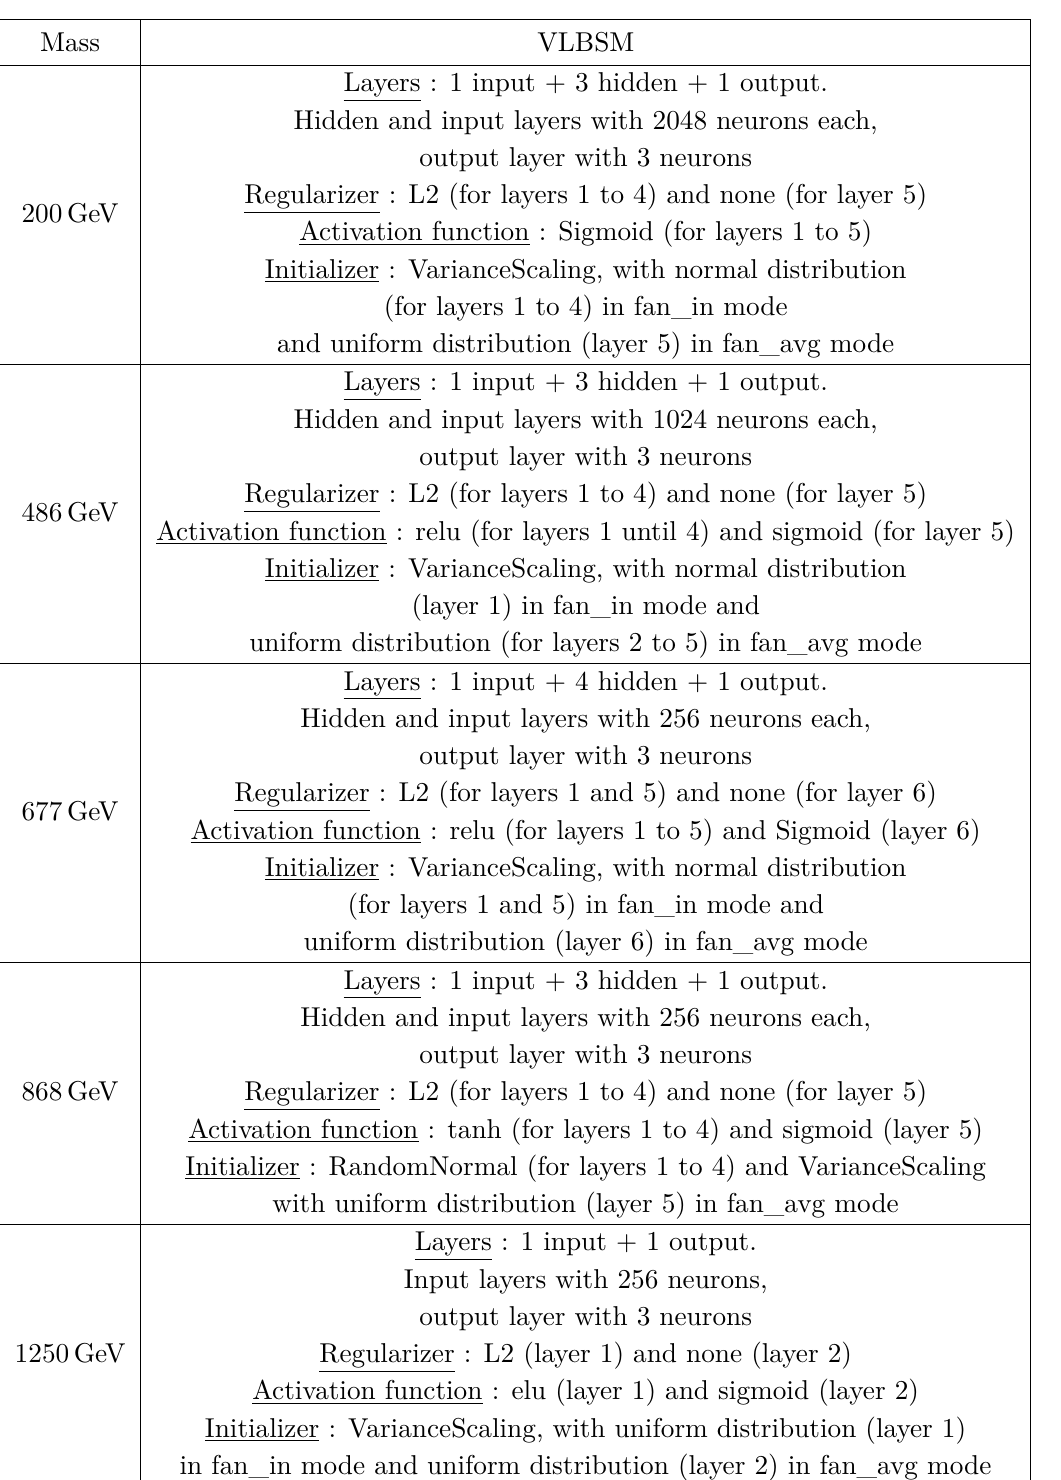
Table 12. Neural networks architectures employed for each mass of the lightest VLL for VLBSM. The architecture is determined following the implementation of an evolutive algorithm that max- imises the accuracy